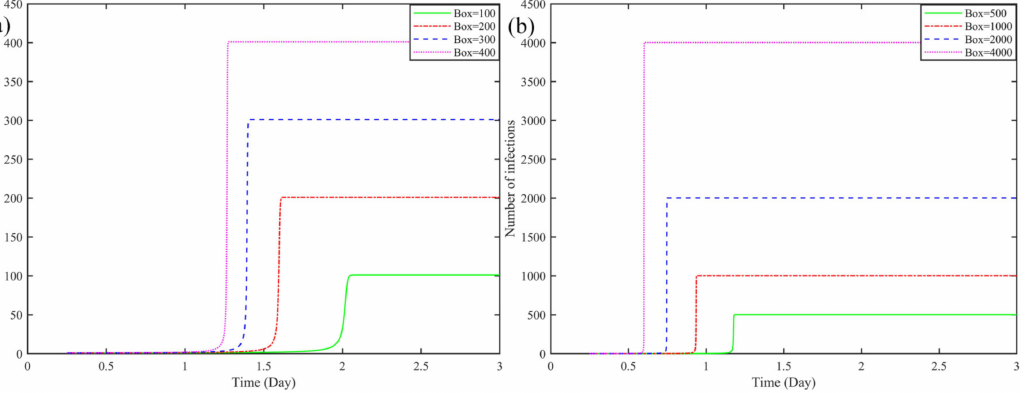
Figure 3. Effect of changes in the number of express boxes on virus transmission in an environment suitable for virus (( a , b ) The subfigures show the lines represented by the different number of boxes).